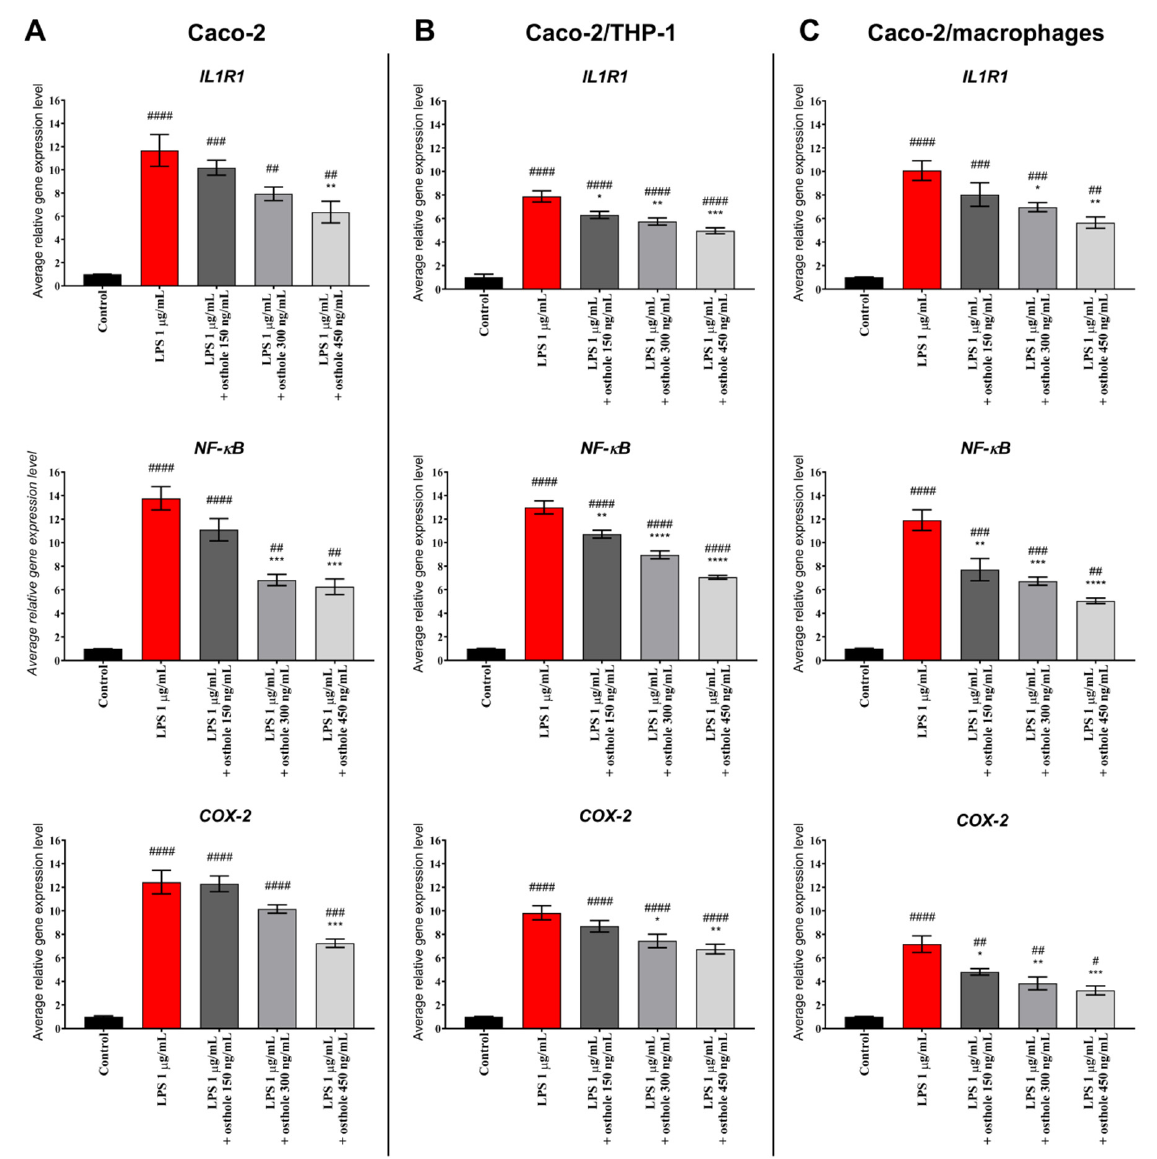
Figure 5. Gene expression level after Caco-2 monoculture ( A ), Caco-2/THP-1 ( B ) and Caco-2/macrohpages ( C ) co-cultures incubation with LPS (1 µ g/mL) and with LPS and different concentrations of osthole (150–450 ng/mL). Horizontal line shows mean and bars depict standard error of mean. Gene expression levels were scaled to the control sample (expression level = 1). Statistically significant differences in comparison to control (#— p < 0.05, ##— p < 0.01, ###— p < 0.001, ####— p < 0.0001) and to cells treated with LPS (*— p < 0.05, **— p < 0.01, ***— p < 0.001, ****— p < 0.0001) are marked.